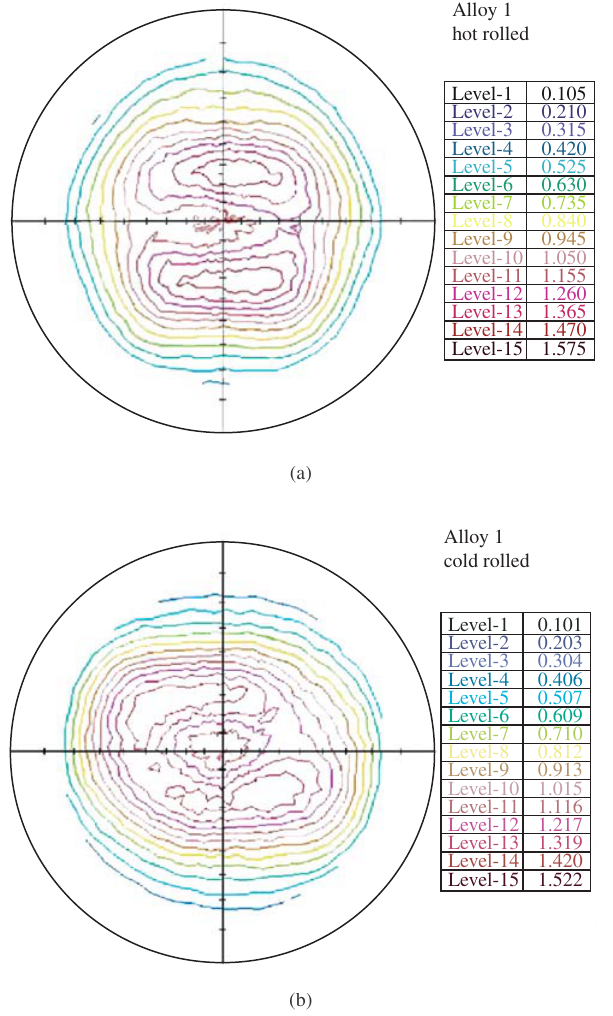
Figure 5. Pole figures obtained from alloy 1. a) After hot rolling up to 72% total reduction in height. b) After cold rolling up to 70% total reduction in height. These pole figures indicate that under the present mechanical working condition, a very low intensity aluminium deformation texture is